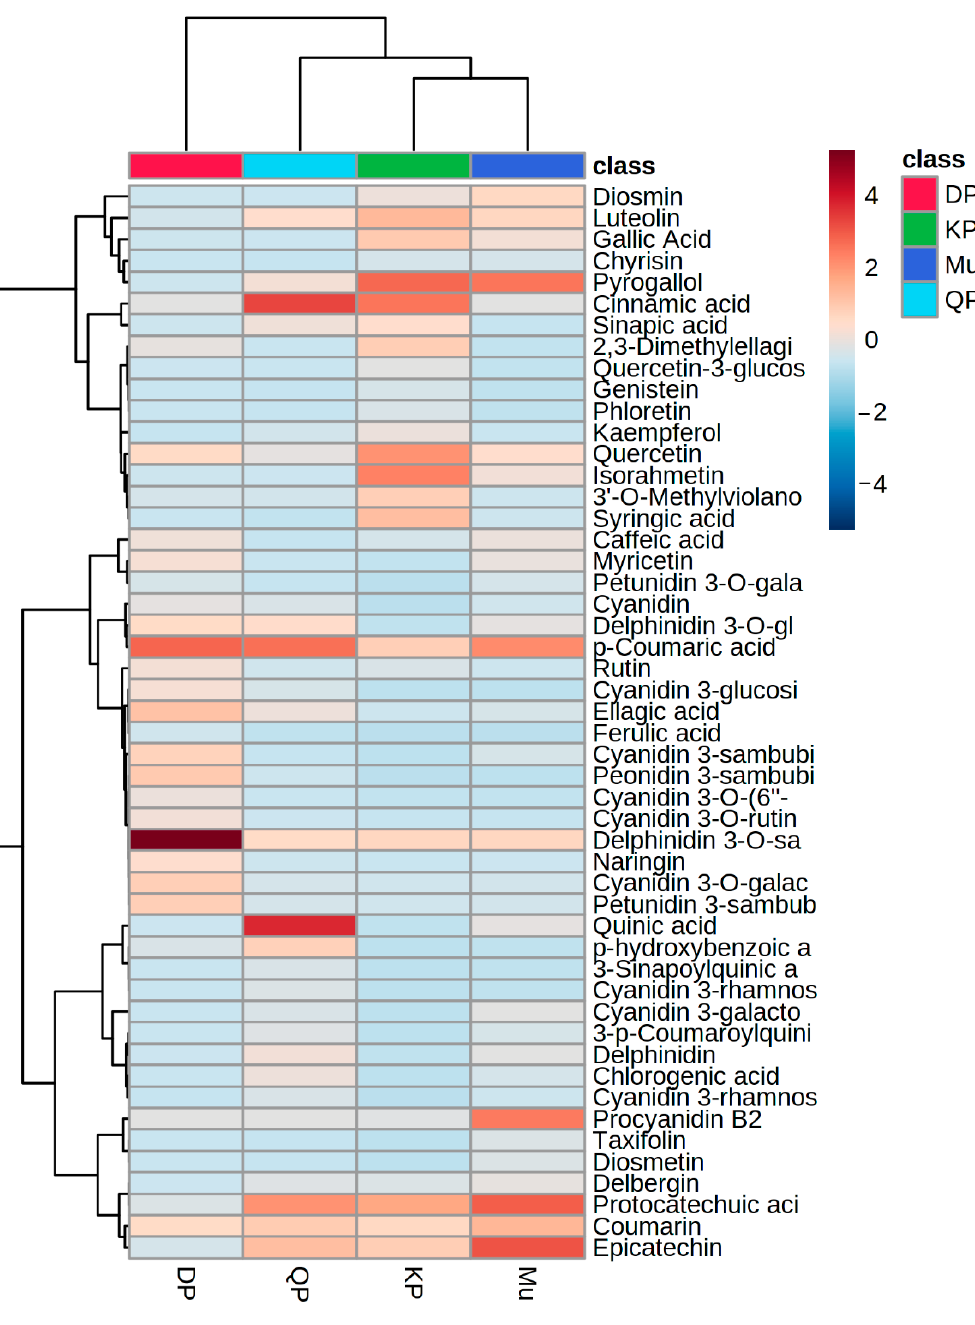
Figure 2. Heatmap hierarchical clustering of quantified phenolic compounds in Davidson plum (DP), Quandong peach (QP), Kakadu plum (KP), and Muntries (Mu). The heatmap shows p -coumaric acid, delphinidin 3- O -sambubioside, peonidin 3- sambubioside, petunidin 3-sambubioside, ellagic acid, and cyanidin 3-galactoside have a higher concentration in Davidson plum while quinic acid, cinnamic acid, protocatechuic acid, delphinidin 3- O -sambubioside were measured higher concentration in quandong peach. Muntries contain a higher concentration of epicatechin, protocatechuic acid, procyanidin B2, p -coumaric acid, and pyrogallol, while Kakadu plum and Muntries were made a cluster with each other. Cinnamic acid, pyrogallol, quercetin, isorhamnetin, and epicatechin showed a higher concentration in the Kakadu plum. 3.3. Distribution of Phytochemical Metabolites in Native Australian Fruits A total of 289, 96, 119, and 210 phytochemical metabolites were tentatively identified in Muntries, Kakadu plum, Davidson plum, and Quandong peach, respectively (Table